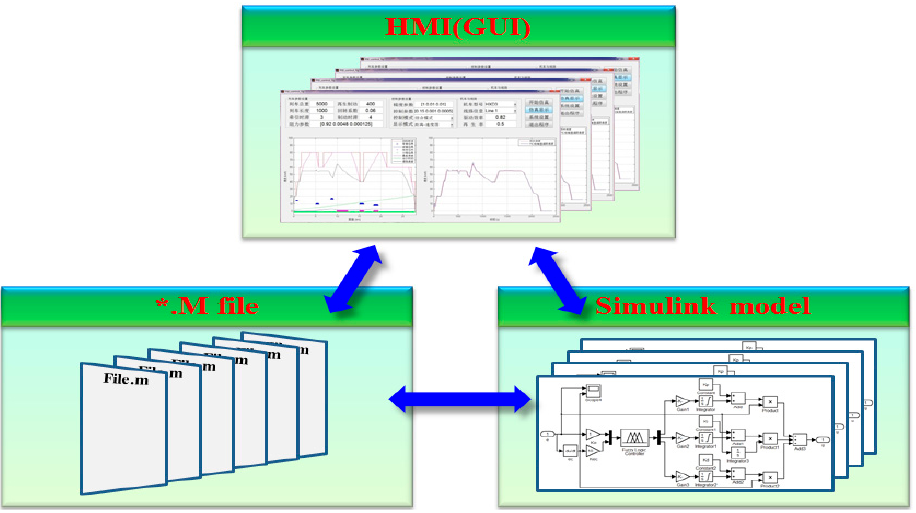
Figure 21. Framework of the simulation platform.